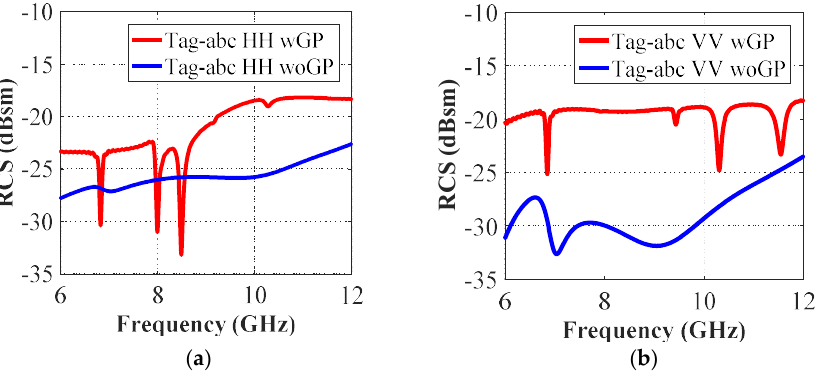
Figure 9. Co-polar RCS simulation results of tag-abc with and without the ground plane under the tag structure ( a ): Co-polar HH RCS responses; ( b ) Co-polar VV RCS responses.